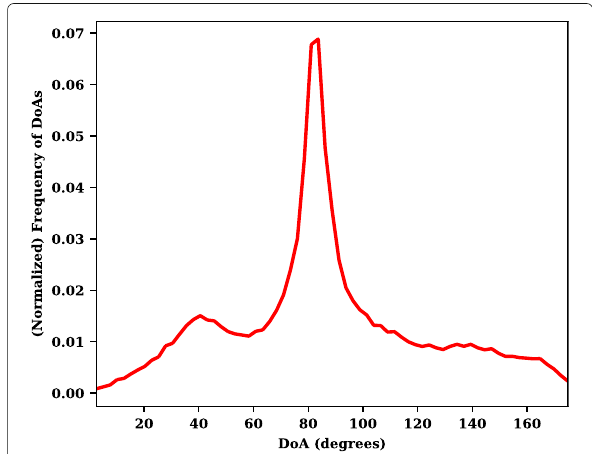
Fig. 10 Histogram of DoA estimates obtained by SRP-PHAT on recording2 ( Task2